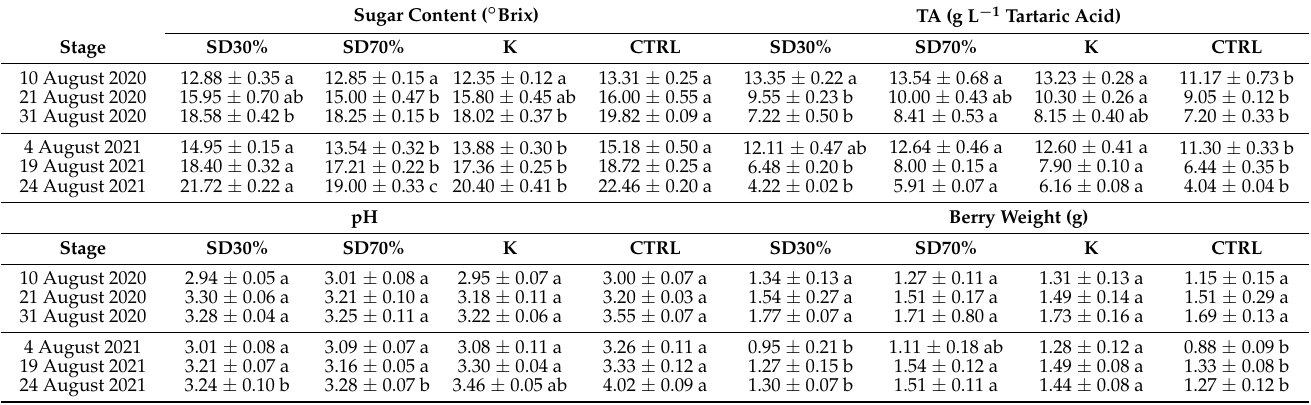
Table 2. Technological maturity. Sugar content ( ◦ Brix), total acidity (TA), pH, and berry weight of Vitis vinifera treated with green artificial shading net at 30% (SD-30%), green artificial shading net at 70% (SD-70%), kaolin (K), and no treatment (CTRL) during two seasons (2020–2021). Measurements were conducted at full veraison (10 August 2020 and 4 August 2021), mid maturation, berries with 24 August 2021). Data (mean ± SE, n = 10) were subjected to one-way ANOVA. In each measured parameter (sugar content, TA, pH, and berry weight) the statistical difference is represented by letters; within the single date, single row, the statistical differences between the treatments (SD30%, SD70%, K, and CTRL) are represented by different letters (a, b, c) (LSD test, p ≤ 0.05). The same letter pictured on different treatments indicates no significant difference among